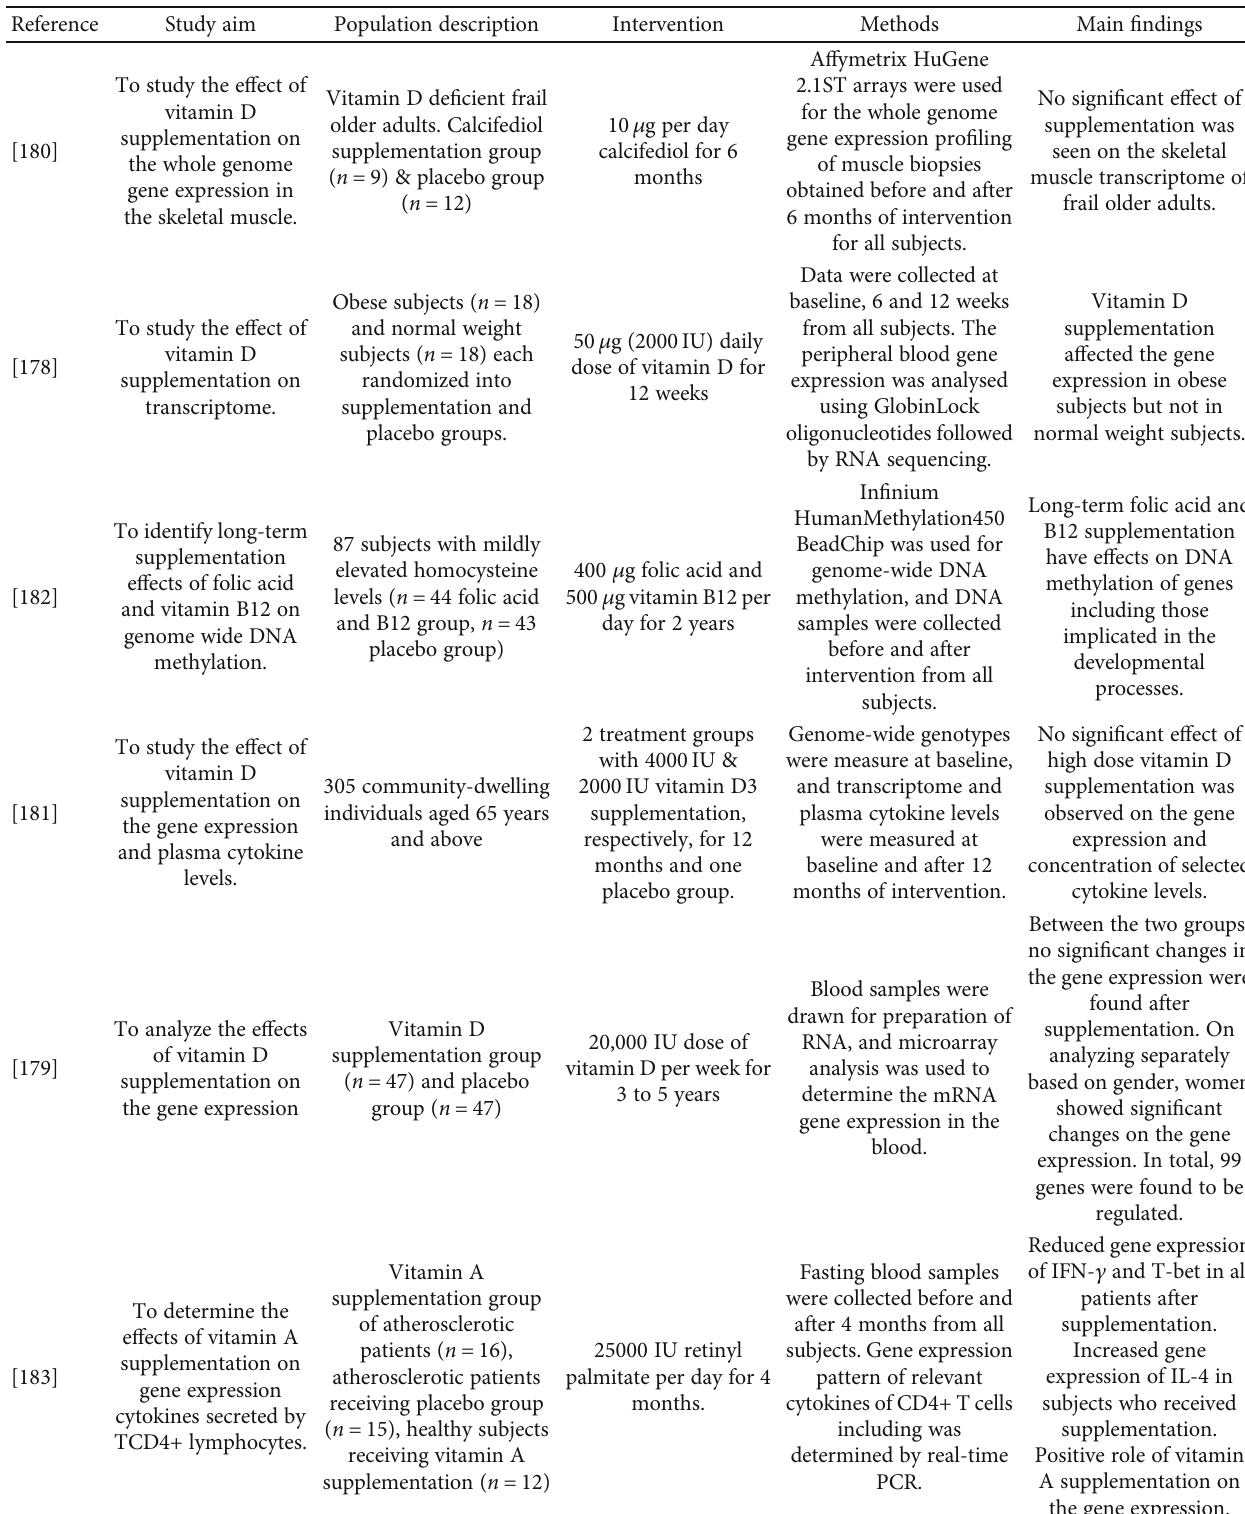
Table 4: Studies related to e ff ects of micronutrient supplementation on the gene expression in nonbariatric surgery